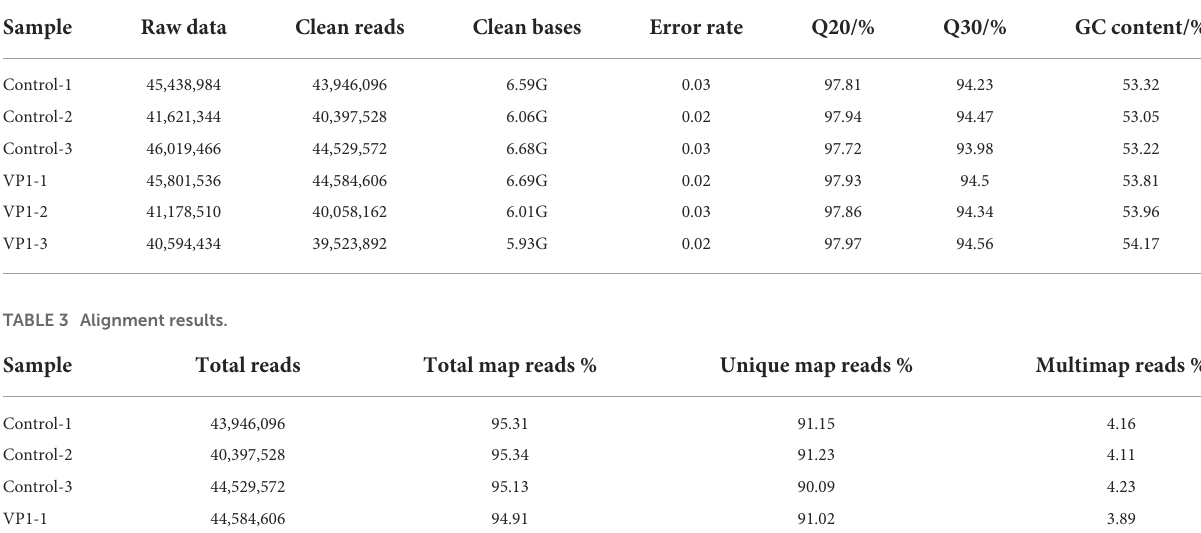
TABLE 2 Statistical analysis of sequencing data.